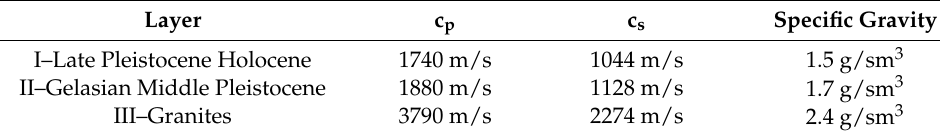
Figure 2. Simulation parameters. Table 1. Parameters of geological layers used in the model.